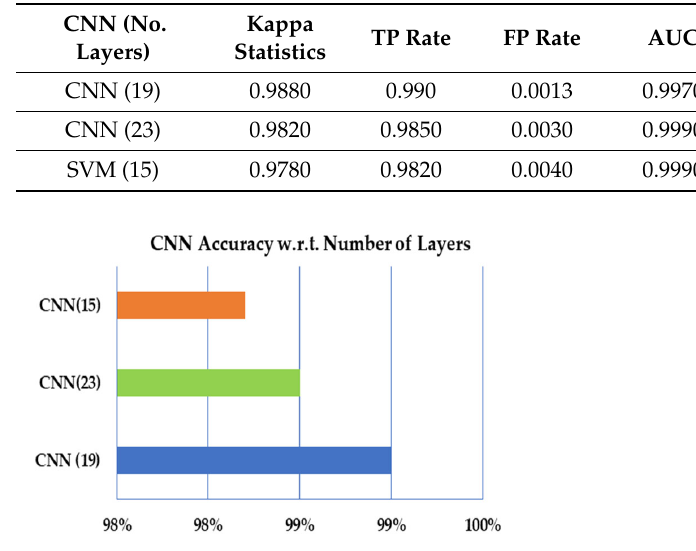
Figure 10. The overall accuracy of CNN with respect to the number of layers.